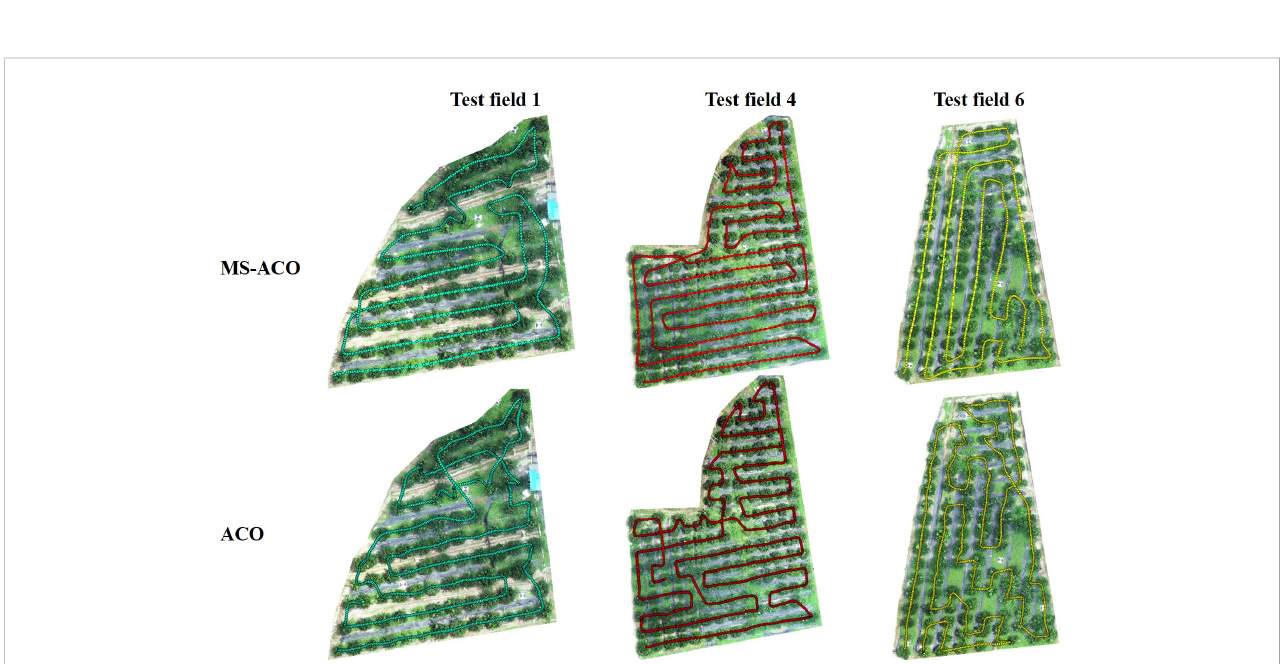
FIGURE 8 GPS fl ight trajectory of MS-ACO algorithm and ACO algorithm to solve the